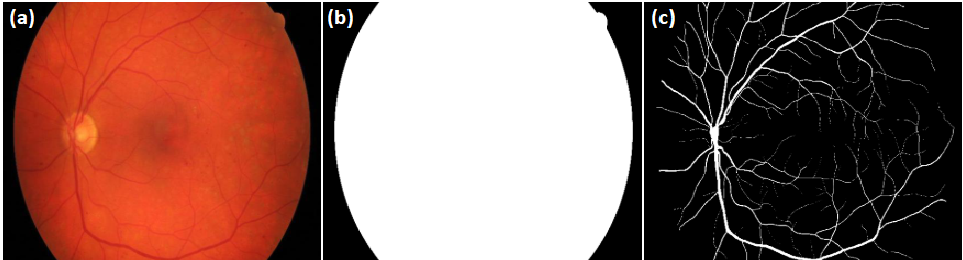
Figure 10. Image example from the HRF dataset: ( a ) the original image; ( b ) FOV-mask image; and ( c ) the manually segmented image of the expert.